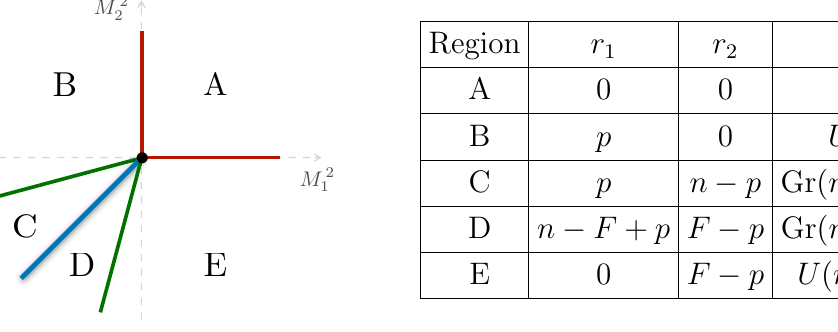
Figure 8 . Phase diagram of the bosonic theory in the case p double condensation coincides with C .